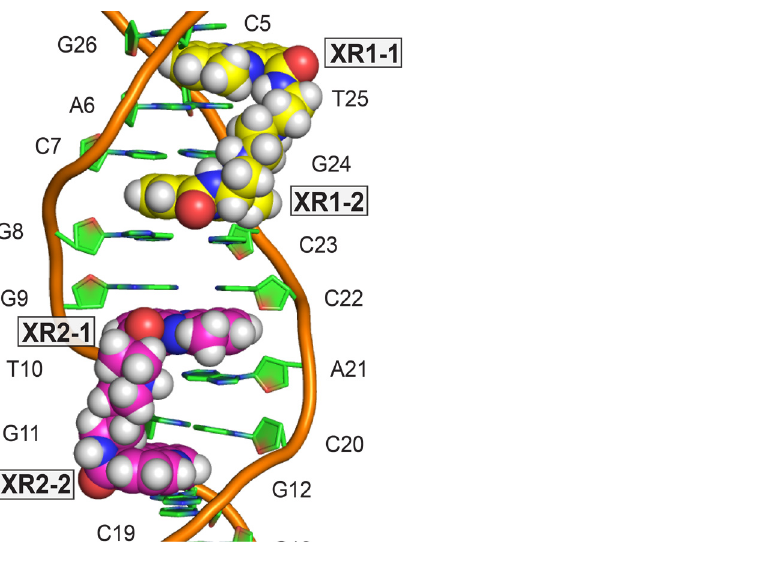
Figure 8. NMR solution structure of 2:1 complex of XR5944 with TFF1 -ERE DNA [PDB: 2MG8]. Model representation of solved structure showing bis-intercalators XR1 (yellow) and XR2 (magenta).